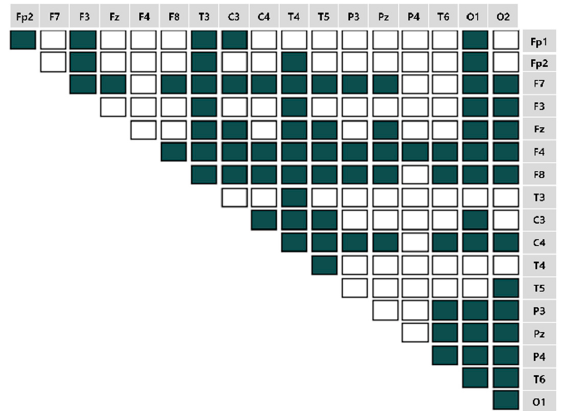
Figure 8. The brain connectivity map in the pleasant-relaxed condition.